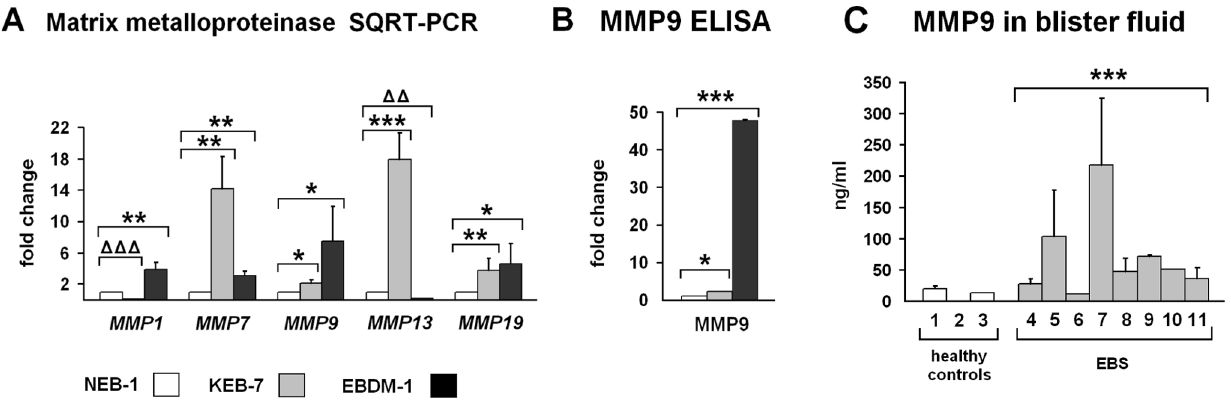
Figure 2. Expression of matrix metalloproteinases. A. SQRT-PCR shows increased matrix metalloproteinase mRNA expression in EBS-DM cell lines (n=4). B. MMP-9 ELISA of 48-h-conditioned cell culture supernatant shows 2-fold upregulation of MMP-9 in KEB-7 and 46-fold upregulation in EBDM-1 at the protein level (n=4). C. MMP-9 levels were highly increased in EBS patients blister fluids compared to healthy controls (n=3 to n=4). The numbers correlate with Table 1. Student`s t -test was performed with p values: * # 0.05, ** # 0.01, *** # 0.005, DD # 0.0005, DDD # 0.0001. (In 2C, the Student’s t -test compared the entire patient group to the entire control group).